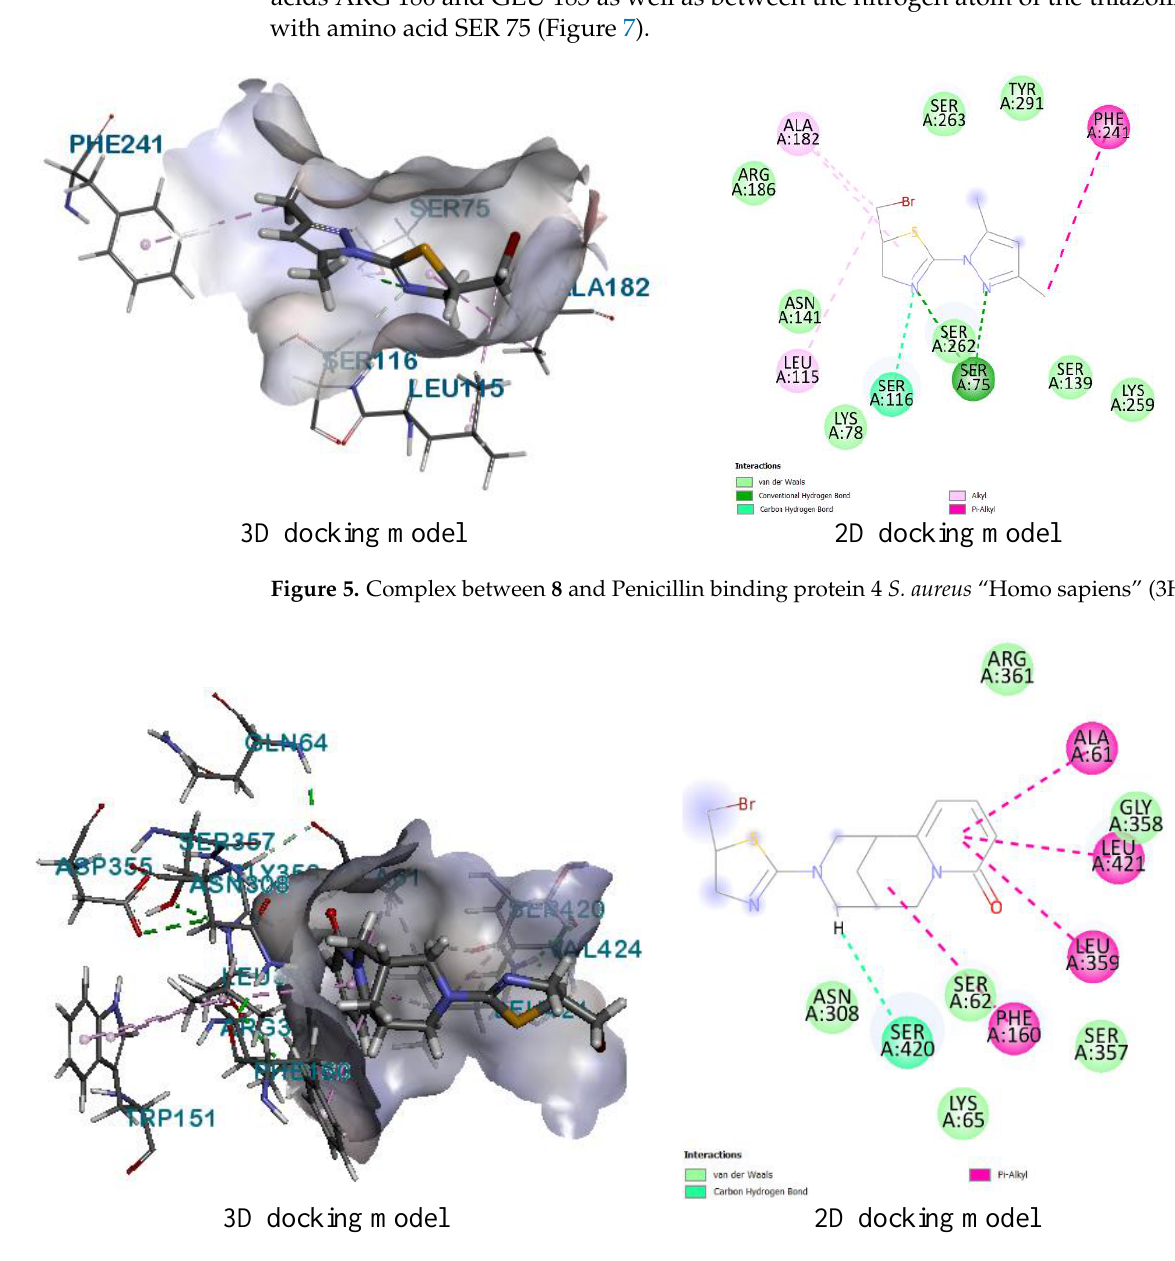
Figure 4. Complex between 8 and Penicillin binding protein 4 E.coli “Homo sapiens” (2EXB). Compound 8 had a weak binding energy of -5.6 kcal/mol with Penicillin binding pro- tein 4 (PBP4) S. aureus “Homo sapiens”, which was associated with the formation of one protein 4 (PBP4) S. aureus “Homo sapiens” due to one carbon-hydrogen bond between the and the pyrazole ring with the amino acid SER 75 (Figure 5). acids ARG 186 and GLU 183 as well as between the nitrogen atom of the thiazoline ring with amino acid SER 75 (Figure 7).